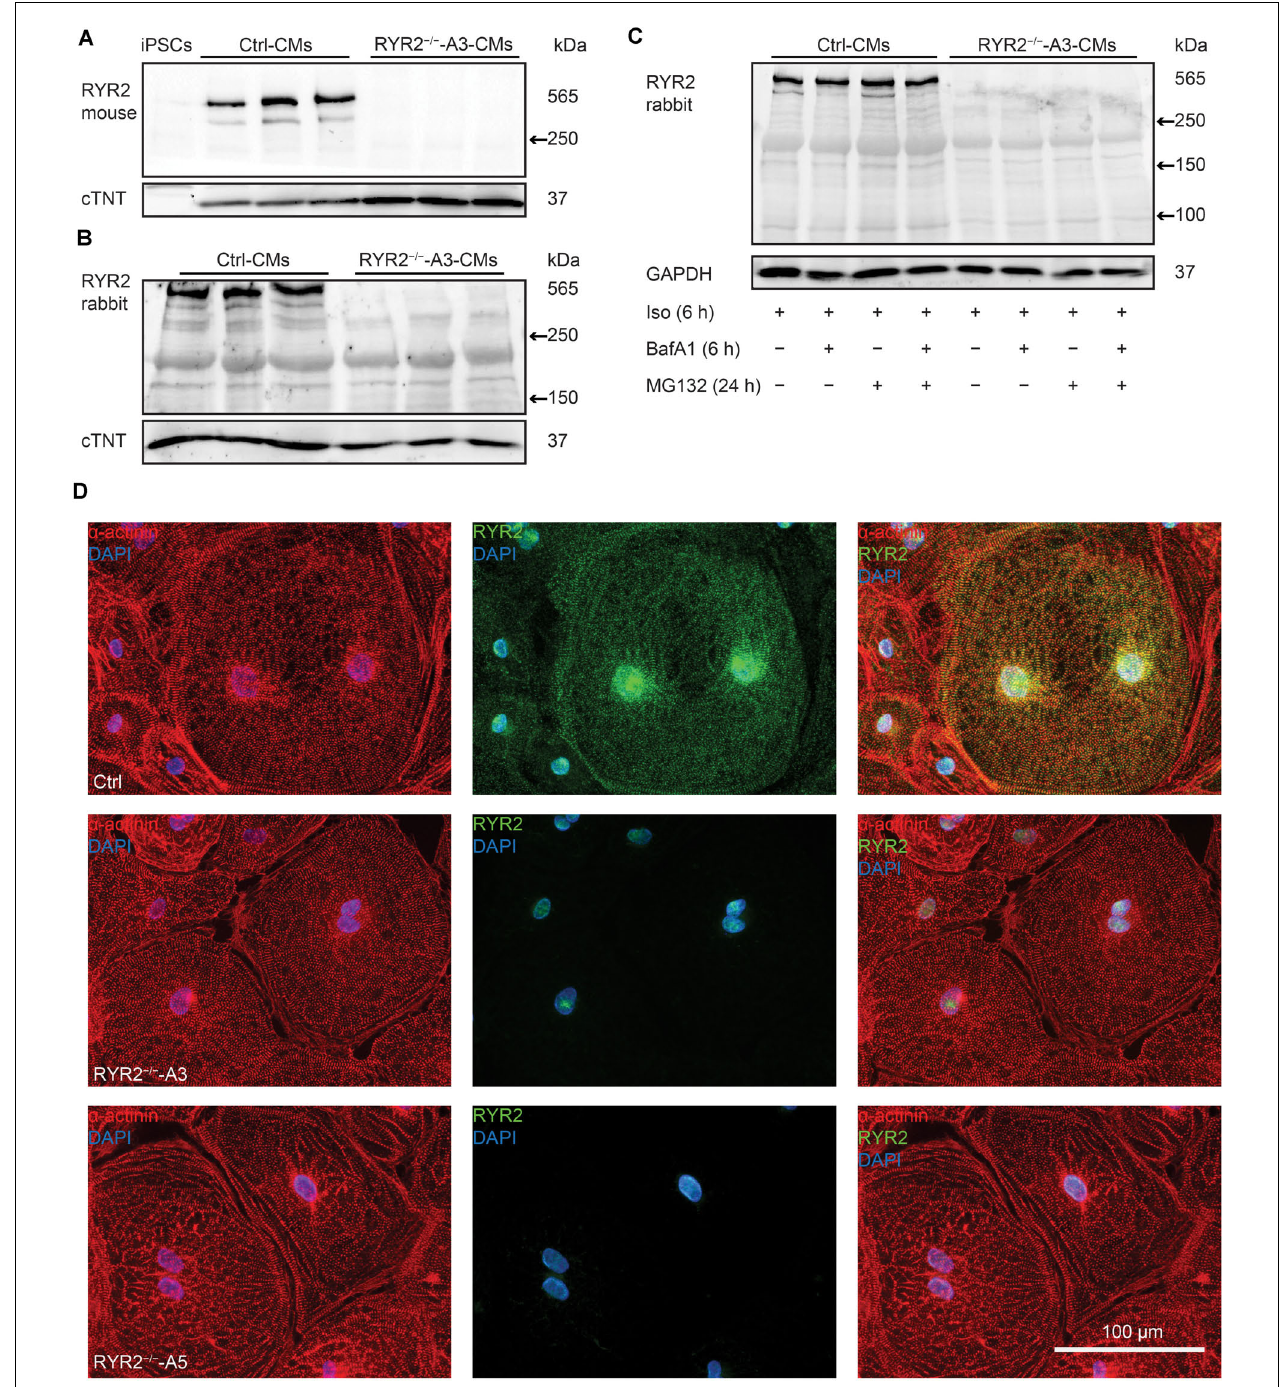
FIGURE 3 | Expression of RYR2 in 3-month-old Ctrl- and RYR2 − / − -iPSC-CMs. (A) Western blot analysis of the full-length RYR2 and cardiac troponin T (cTNT) in Ctrl- and A3 RYR2 − / − -iPSC-CMs (Ctrl: n = 3 and A3 RYR2 − / − : n = 3 independent differentiation experiments). (B) Western blot analysis showing protein expression of N-terminal RYR2 and cTNT in Ctrl- and A3 RYR2 − / − -iPSC-CMs (Ctrl: n = 3 and A3 RYR2 − / − : n = 3 independent differentiation experiments). (C) Representative western blot analysis of RYR2 in response to treatment with MG132 and/or Bafilomycin A (BafA1) in Ctrl- and RYR2 − / − -iPSC-CMs (Ctrl: n = 3, A3 RYR2 − / − : n = 3 independent differentiation experiments). No degraded RYR2 proteins were detected in RYR2 − / − -iPSC-CMs by inhibiting protein degradation with the proteasome and calpain inhibitor MG132 and the autophagy inhibitor BafA1. (D) Representative immunostaining of Ctrl- and RYR2 − / − -iPSC-CMs using antibodies against RYR2 (green) and α -actinin (red). The cells were counterstained with DAPI (blue) to show the nucleus. Scale bar, 100 µ m.